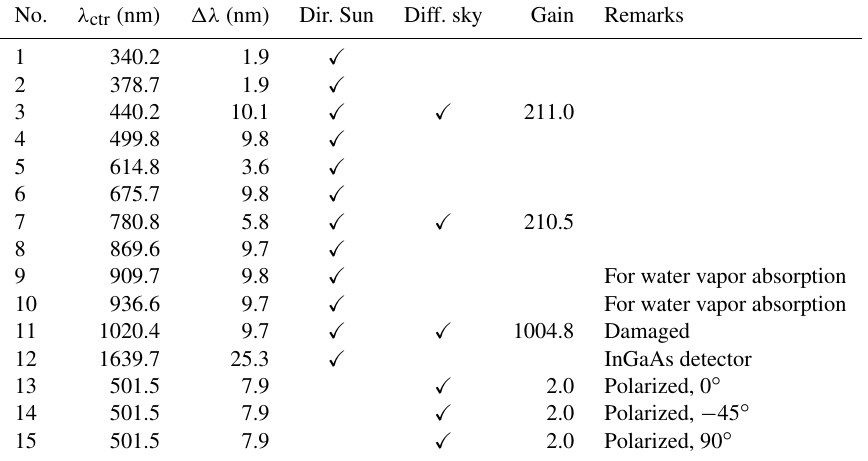
Table 1. SSARA channel configuration from 23 January 2017 onward. λ ctr is the central wavelength of the filter; (cid:49)λ is its full width at half maximum. “Gain” gives the amplification of the second amplifier stage if installed for the corresponding channel. The “dir. Sun” and “diff. sky” columns indicate whether the channel can be used for direct Sun or diffuse sky radiance measurements, respectively. InGaAs refers to indium gallium arsenide. No. λ ctr (nm) (cid:49)λ (nm) Dir. Sun Diff.